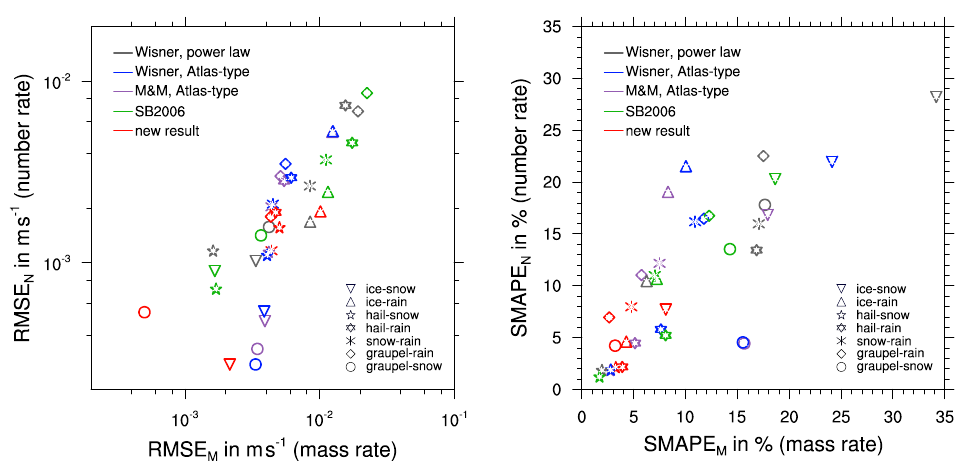
Fig. 9. Root mean square error (RMSE, left) and symmetric mean absolute percentage error (SMAPE, right) of the normalized bulk number and mass collection rates for seven different binary collision interactions.